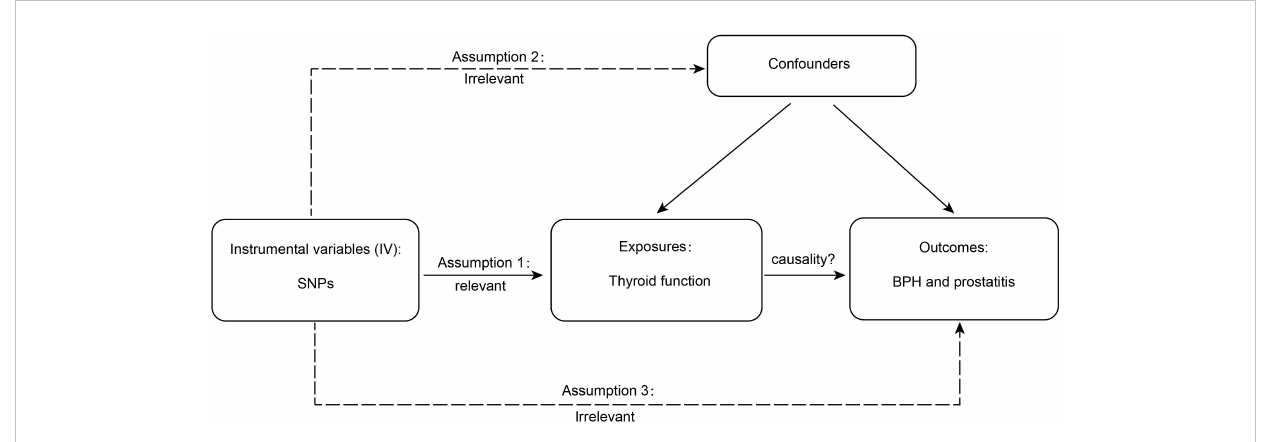
FIGURE 1 The detailed principles of Mendelian randomization study. BPH, benign prostatic